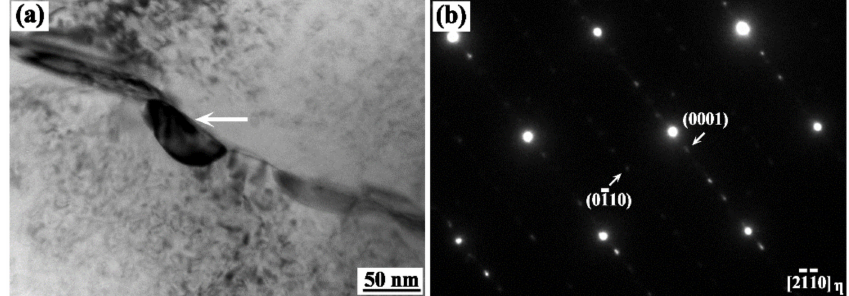
Figure 3. ( a ) Bright-field TEM image and ( b ) the corresponding selected area electron di ff raction (SAED) pattern of the precipitate at the grain boundary in alloy 4 after direct aging heat